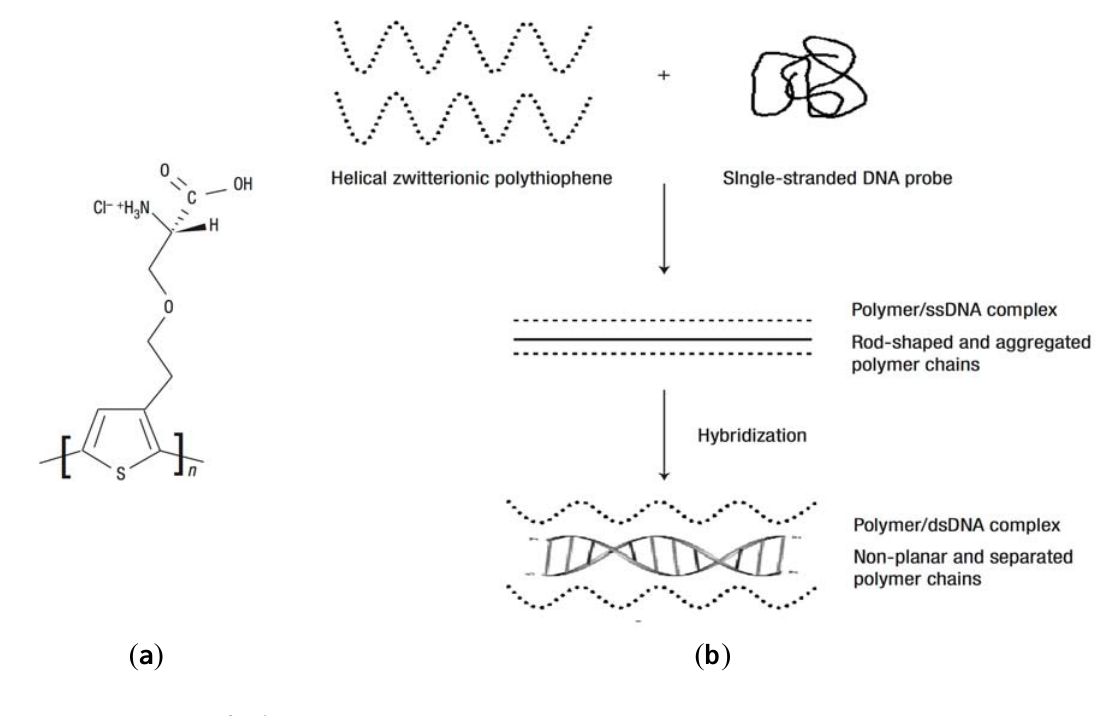
Figure 8. ( a ) The repeat unit of poly(3-[(S)-5-amino-5-carboxyl-3-oxapentyl]-2,5- thiophenylene hydrochloride) (POWT) and ( b ) formation of a POWT/DNA probe complex. Geometrical changes of POWT (dotted lines) upon hybridization with ssDNA (solid lines) and formation of the double-stranded, helical DNA structure (dDNA). (Reproduced with permission from